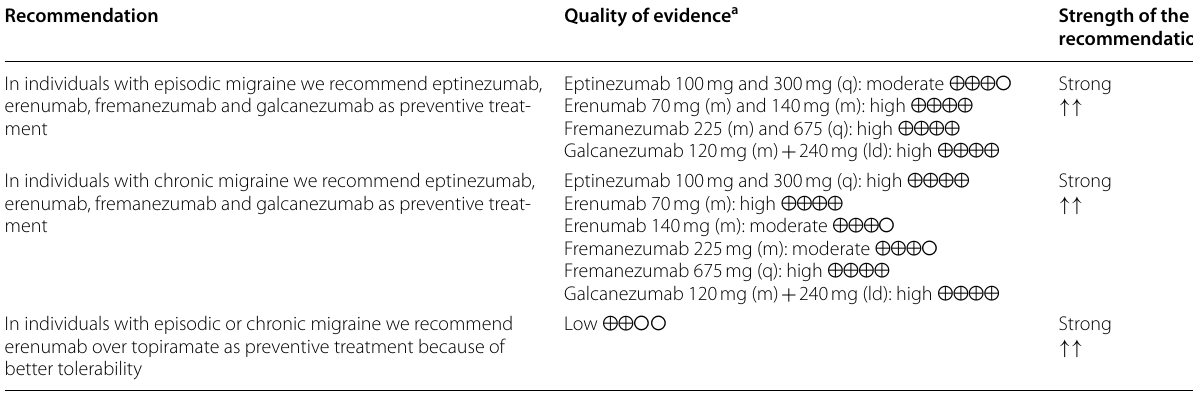
(m) indicates monthly, (q) indicates quarterly, ld indicates loading dose a For drugs with differences in the quality of evidence across the different outcomes we provided the overall rating according to the highest quality of evidence since the risk of bias was considered minor